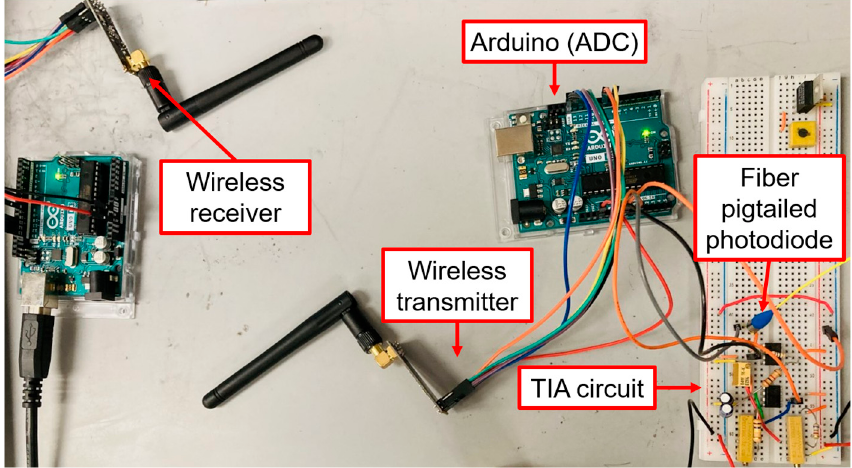
Figure 7. Entire setup of the low-cost and wireless interrogator circuit.